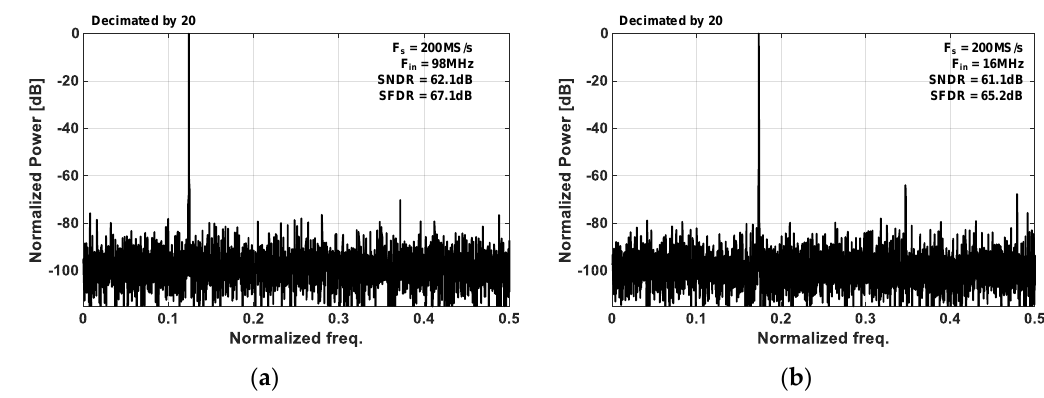
Figure 17. Measured spectrum at 200 MS/s with: ( a ) Nyquist input; ( b ) 16 MHz input. Reprinted with permission from Ref. [22]. Copyright 2019 the Japan Society of Applied Physics.